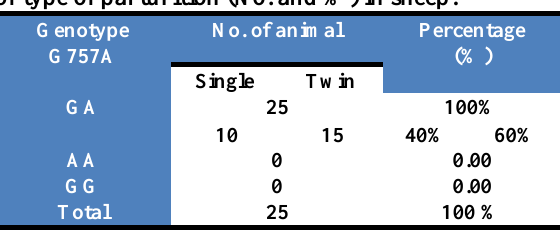
Table, 4: Distribution of genotype G757A according of type of parturition (No. and %) in sheep.